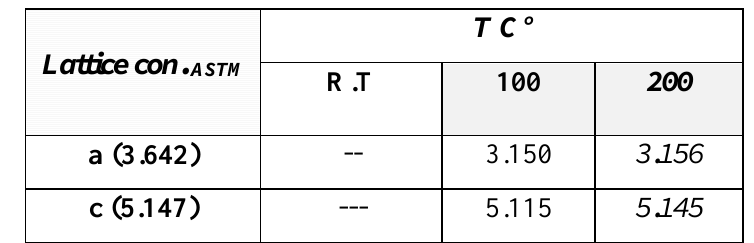
Table 2: Lattice constant of Se thin